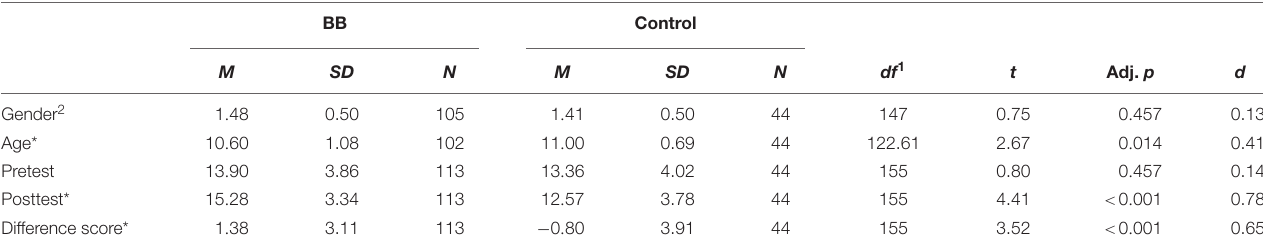
TABLE 1 | Descriptive statistics and comparison of the balance beam (BB) and control conditions on gender, age, pretest and posttest balance beam scores, and the difference between pretest and